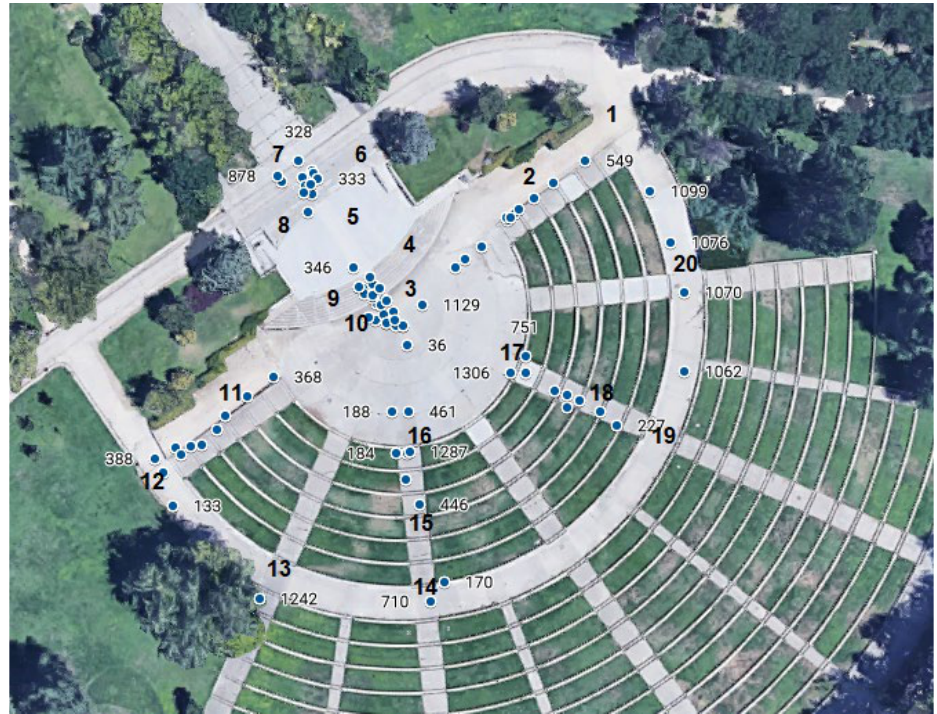
Figure 2. Location of some multivariate outliers in the different classes or zones. (Image taken from Google Maps).